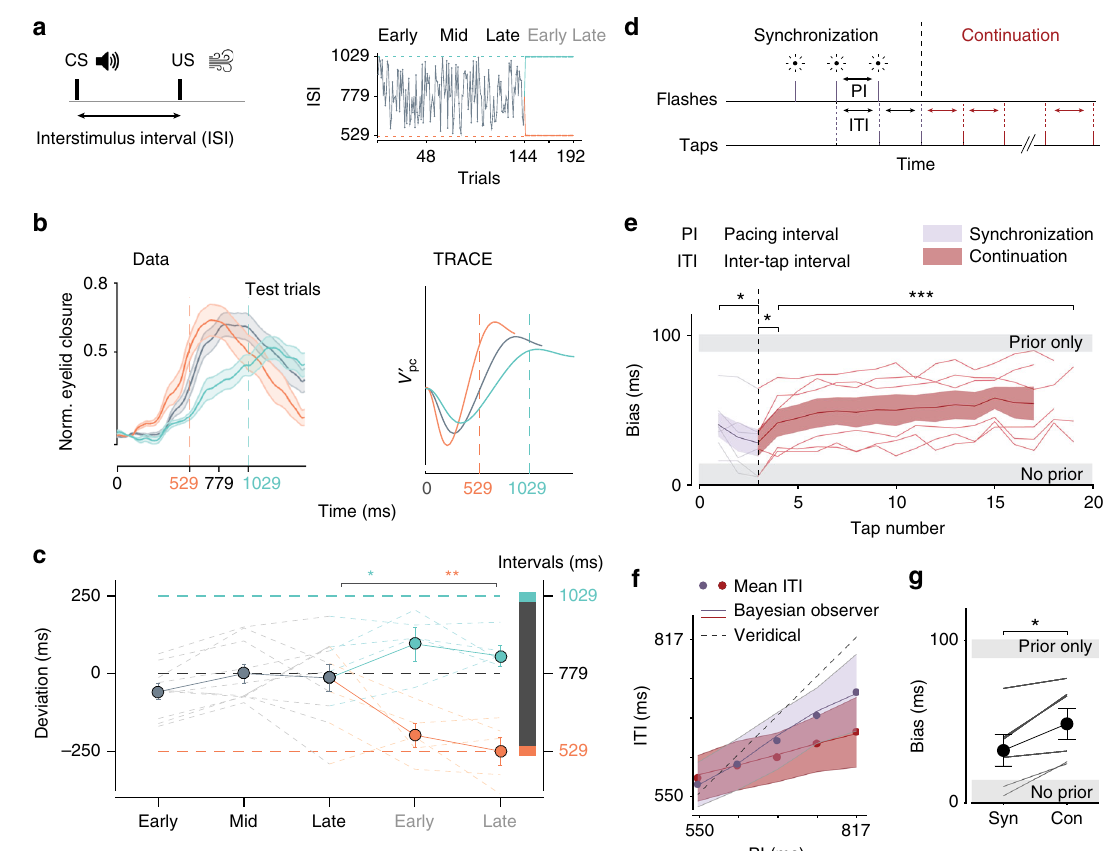
Fig. 8 Prior-dependent biases in cerebellar timing tasks in humans. a Left: trace eyeblink conditioning using tone as the conditioned stimulus (CS) and airpuff as unconditioned stimulus (US), with interspersed test trials (CS-only). The two stimuli were separated by an interstimulus interval (ISI). Right: ISI within a behavioral session was drawn randomly from a uniform distribution ranging between 529 and 1059ms (gray) for the fi rst 144 trials. Afterwards, ISI was switched to a single valued distribution (i.e., delta function), either a fi xed 529 ms (orange) or a fi xed 1059 ms (green). b Left: normalized average eyeblink closure traces as a function of time after CS in the test trials before (gray) and after (orange/green) the switch. Right: TRACE predictions for the same distributions. c Deviation of peak eyelid closure time from the mean of the wide uniform ISI distribution. The deviation is computed in early (1 – 48), middle (49 – 96), and late (97 – 144) stages before the switch, and in early (145 – 168) and late (169 – 192) stages after the switch. Circles indicate averages and faint lines individual participants. Error bars indicate SEM. d Synchronization-Continuation task. In the ‘ Synchronization ’ phase, participants tapped in synchrony with isochronous fl ashes (with pacing interval PI) and continued tapping in the ‘ Continuation ’ phase with an inter-tap-interval (ITI). PI was a fi xed within trials and sampled from a uniform distribution across trials. e Bias in the synchronization (purple) and continuation (red) phases for all participants (thin lines) and their averages (thick lines). The magnitude of bias for all participants lay between two extremes, a hypothetical observer that does not rely on the prior (lower gray bar, no prior), and a hypothetical observer that only uses the mean of the prior (upper gray bar, prior only). f An example participant. Filled circles represent the mean ITI corresponding to each PI for synchronization (purple) and continuation (red). Solid lines correspond to a Bayesian observer model fi t to the participant ’ s data. Dashed line indicates veridical performance. g Comparison of bias between synchronization and continuation phases for individual participants (gray) and averages (solid black). In e , f shaded regions and error bars show